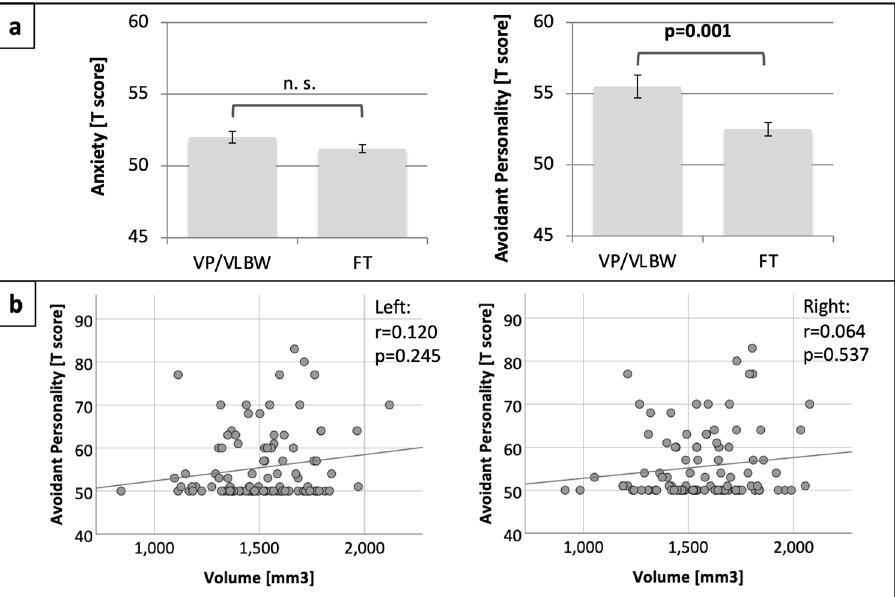
Figure 3. ( A ) Group comparisons between YASR anxiety and avoidant personality scores. Mean T scores are shown as bar charts with SE as error bars. Bold letters indicate statistical significance. ( B ) Relationship between whole amygdala volume and avoidant personality score. The associations between left and right whole amygdala volume and the avoidant personality T score are shown as scatter plots. Whole amygdala volumes (in mm 3 ) are plotted on the x-axes. The T score is plotted on the y-axes. Linear regression lines as well as correlation coefficients and p -values were added. Bold letters indicate statistical significance after FDR correction using the Benjamini–Hochberg procedure. BW, birth weight; FT, full term; GA, gestational age; L, left; n. s., not significant; R, right; VP/VLWB, very preterm and/or very low birth